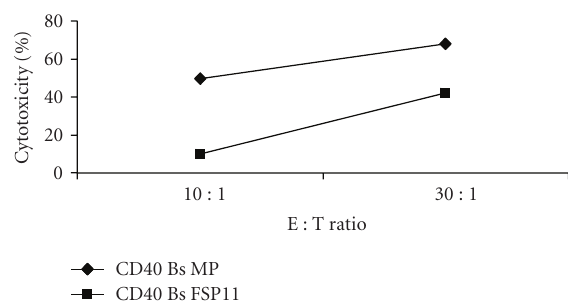
Figure 3: Target inhibition. FSP11 specificity and HLA-A0201 restriction of target cell lysis of FSP11-specific T cells were tested at two di ff erent E : T cell ratios (10 : 1, 30 : 1) in the presence of an excess of unlabeled target cells (CD40 Bs pulsed with either FSP11 (square) or control peptide MP (diamond)) at an unlabeled: labeled target cell ratio of 20 : 1). Displayed is the percentage of labeled and FSP11-loaded CD40 Bs killed by the FSP11-specific T cells. A representative experiment of three is shown. Analysis was performed after a 6-hour incubation period.